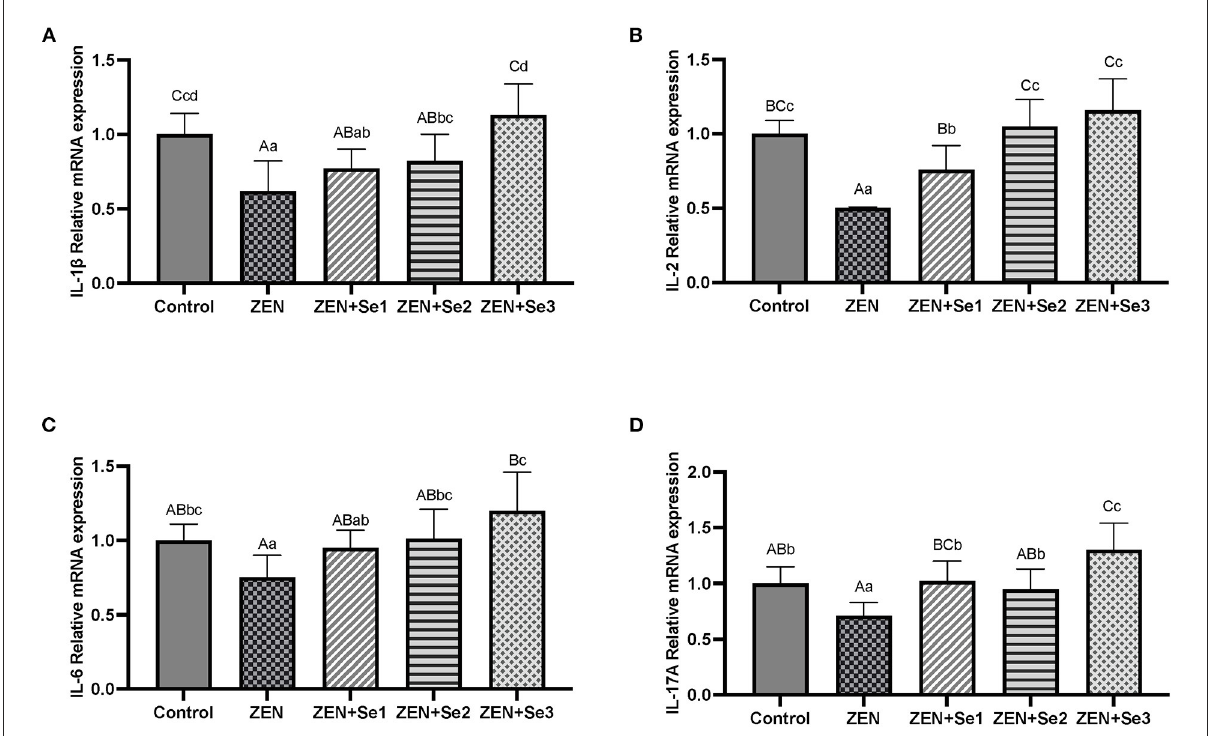
FIGURE4 Effects of SC on the liver contents of ILs induced by ZEN in mice: (A) IL-1 β ; (B) IL-2; (C) IL-6; (D) IL-17A. Different capital letters (lowercase letters) in the column chart indicate a significant difference at the 0.01 (0.05)